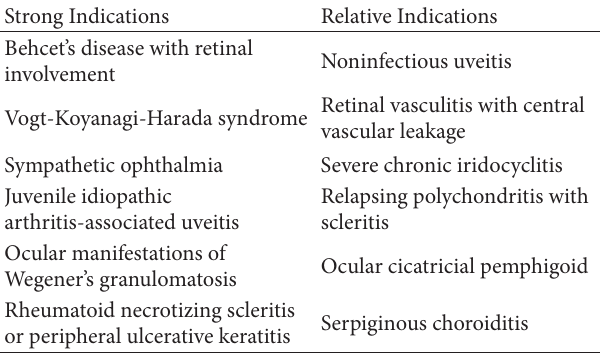
Table 1: Disease indications for immunosuppressive agents. Strong Indications Relative Indications Behcet’s disease with